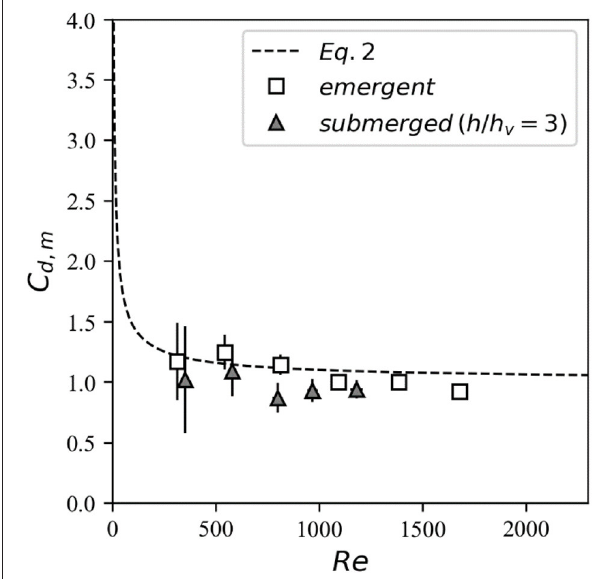
FIGURE 5 | Drag coefficients derived from the velocity and drag force measurements for the isolated cylinder cases. = velocity in Equation (3) to relate a given flow condition to the canopy drag force through a drag coefficient (i.e., C d , b and C d , p , respectively). Here, when using both the bulk velocity ( U em ) and pore velocity ( U em ) are used as the drag reference p b velocity, there are large discrepancies with values for isolated cylinders (Equation 2), similar to results reported in other studies (e.g., Liu and Zeng, 2017). For the highest density canopies ( λ p 0.1), there is an exponential decrease in the drag = coefficient with Reynolds number using both the bulk velocity U em ( Figure 6A , squares) and pore velocity U em ( Figure 6B p b